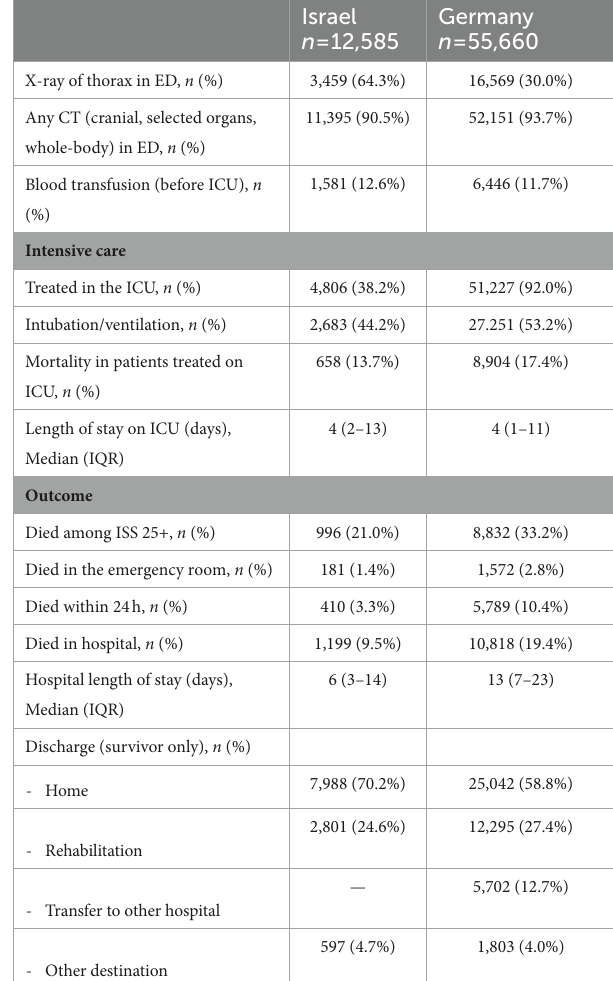
TABLE 3 Characteristics of adult severe trauma patients in Israel and